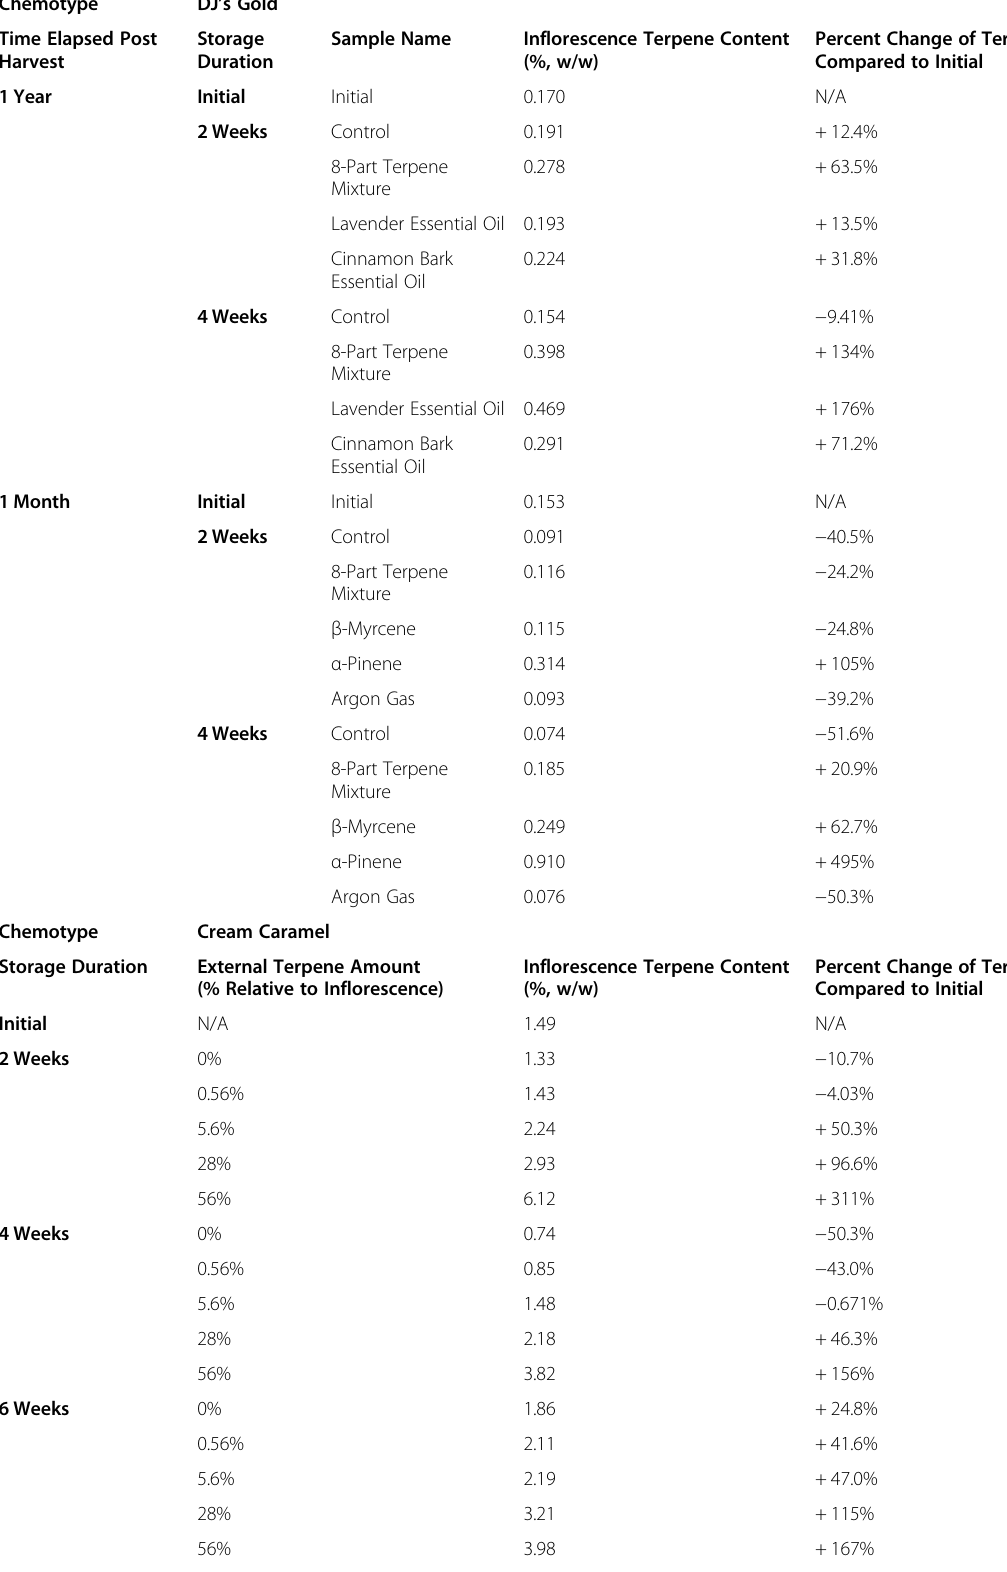
Table 1 Summary of